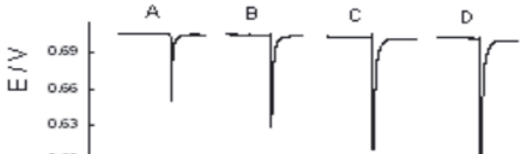
Figure 4. The profiles of adding samples close to the point of